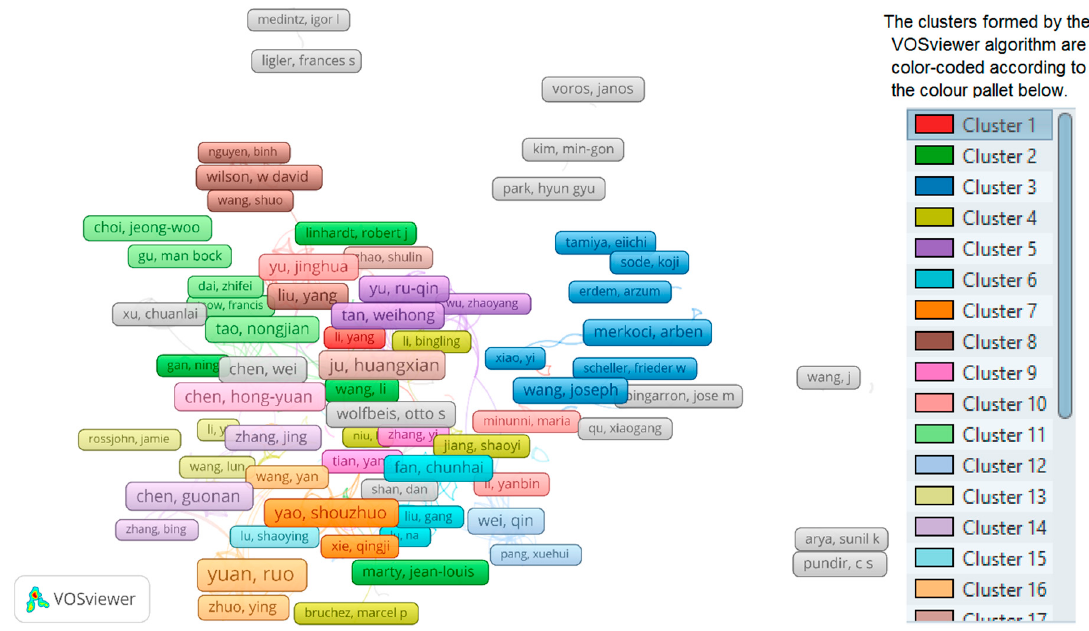
Figure 16. Co-authorship based on authors. The clusters formed by the VOSviewer algorithm are colour-coded according to the colour pallet shown on the right-hand side. Table 3. List of top ten authors in the first five co-authorship clusters.